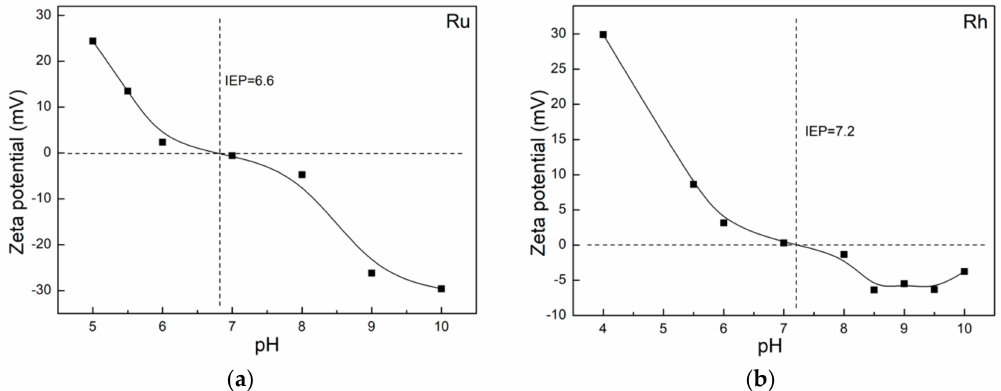
Figure 6. pH vs. ζ -potential of PVP-coated ( a ) Ru (Ru-2) and ( b ) Rh (Rh-2) NPs dispersed in DI water. The pH is tuned by dropwise addition of hydrochloric acid (0.1 M) or sodium hydroxide solution (0.1 M)